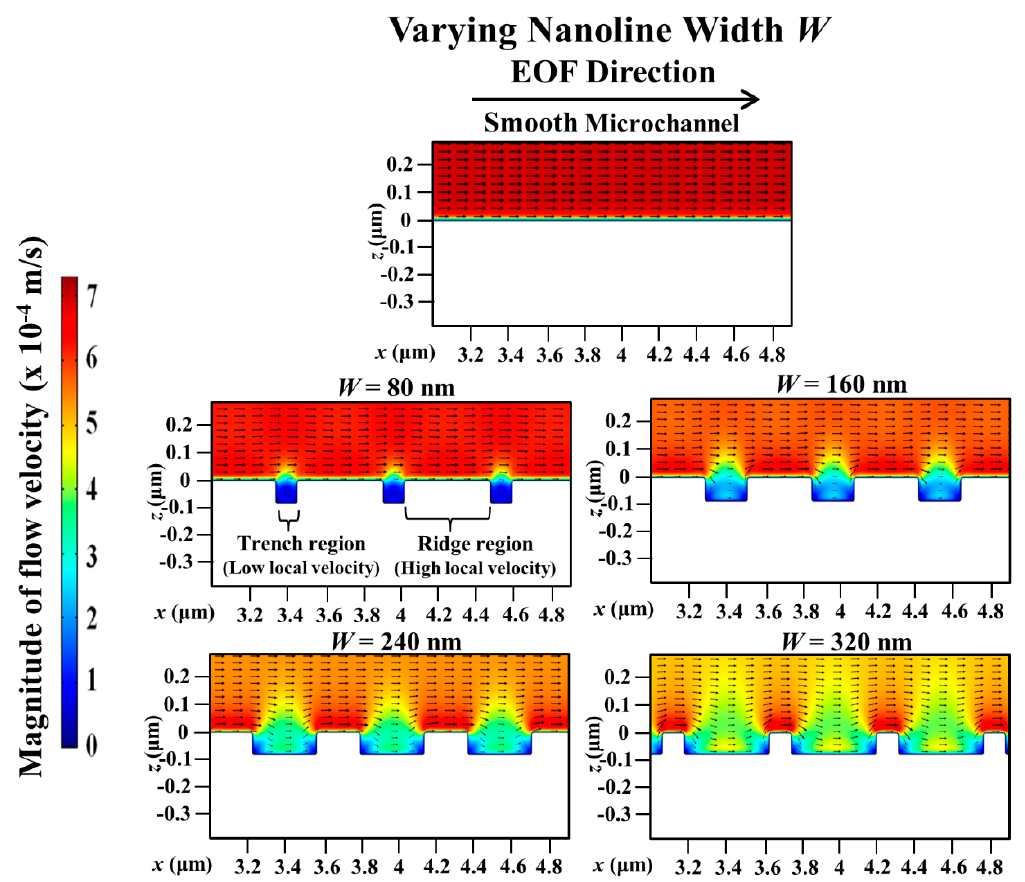
Figure 7. Simulated electroosmotic flow (EOF) velocity profile in microchannel with varying nanoline width W , in comparison to smooth microchannel. Sodium bicarbonate (NaHCO 3 ) concentration was fixed at 1.0 mM, and nanoline orientation angle θ , period P , and depth D were fixed at 45°, 400 nm, and 90 nm, respectively. As W increases, the narrowing of ridge causes flow reduction and more asymmetric EOF profile.